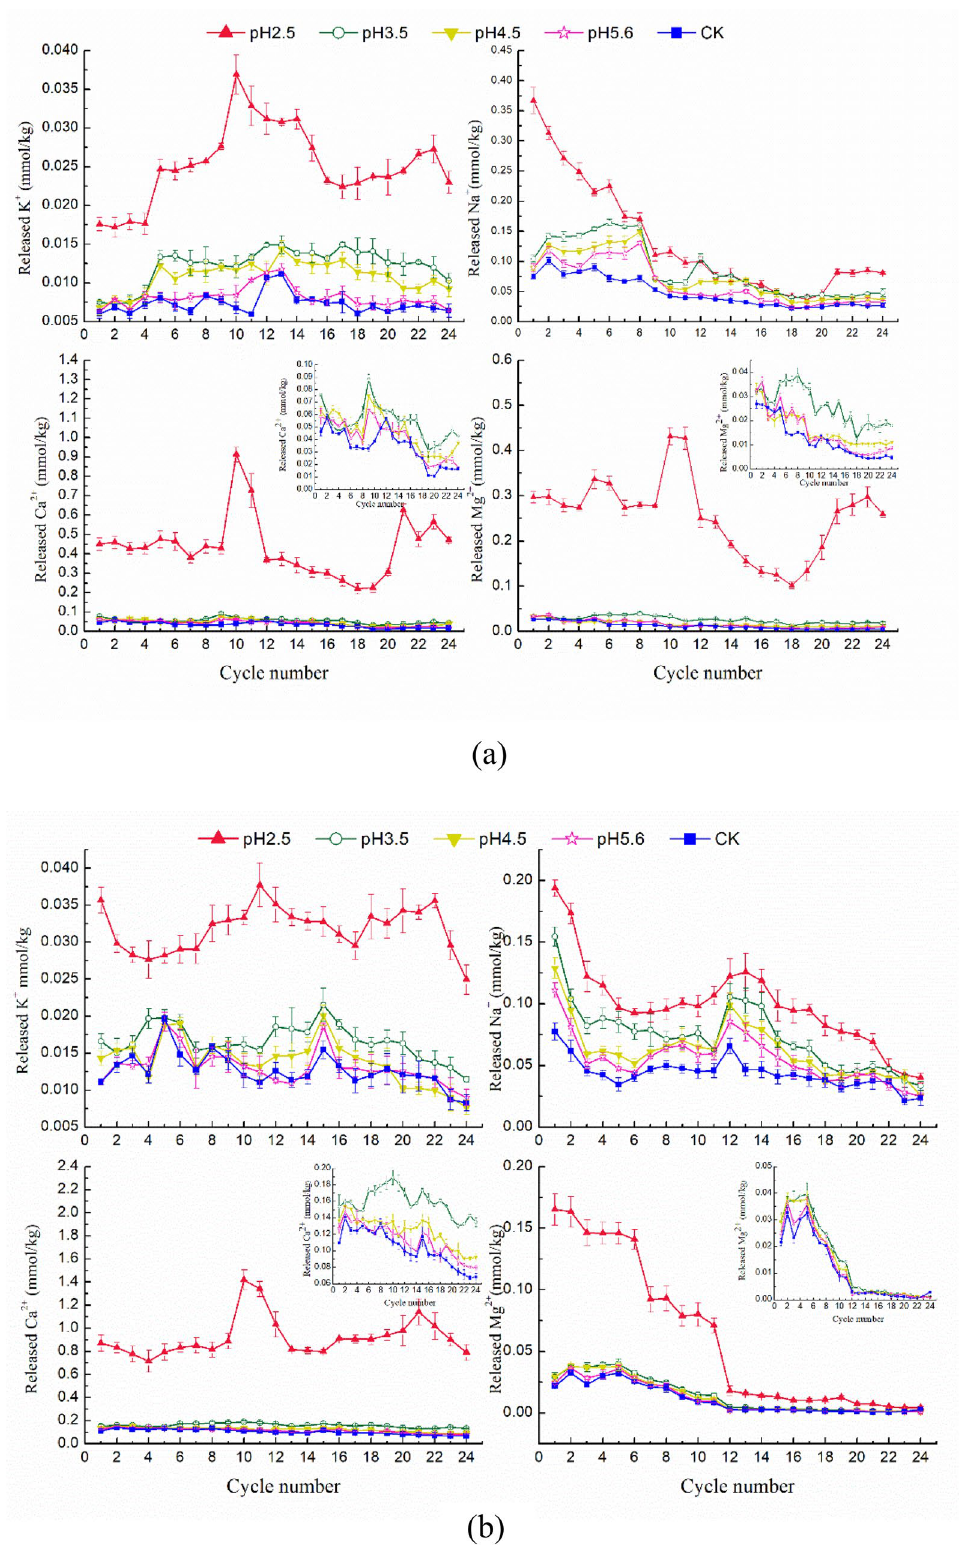
Figure 3. Cations released in the soaking solution from J 2 s ( a ) and J 3 p ( b ) after each treatment cycle. The inserts in figure show enlargements of the parts of released Ca 2+ and Mg 2+ with the pHs of 3.5, 4.5, 5.6 and